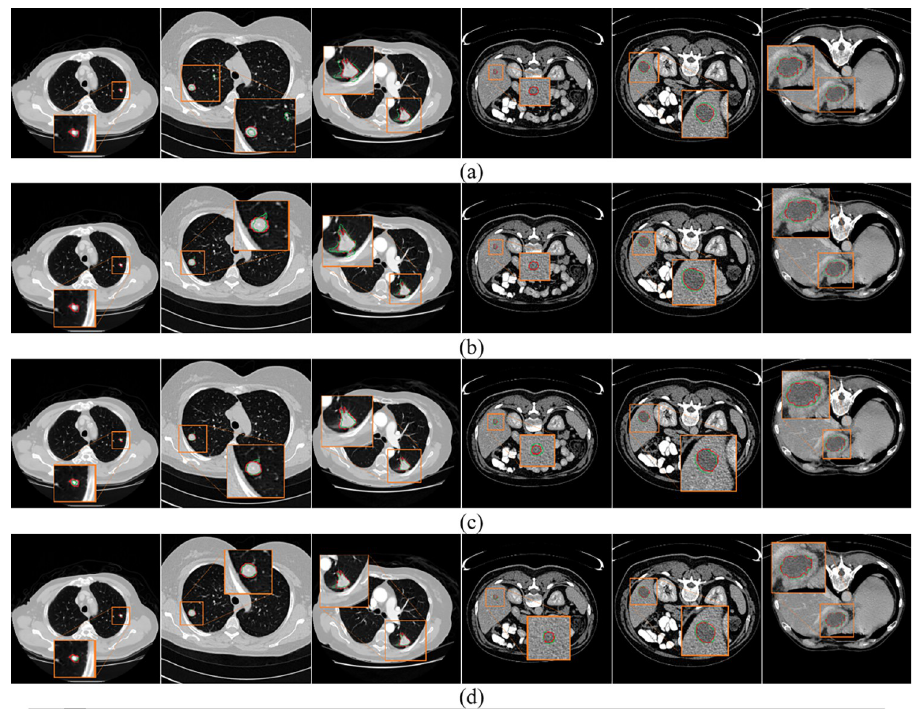
Fig 13. A visual comparison of the lesion segmentation results. (a)t-aug. (b)sp-aug. (c)mix-aug. (d)mof-aug. The red and green contours denote the ground truth and the segmentation results, respectively.